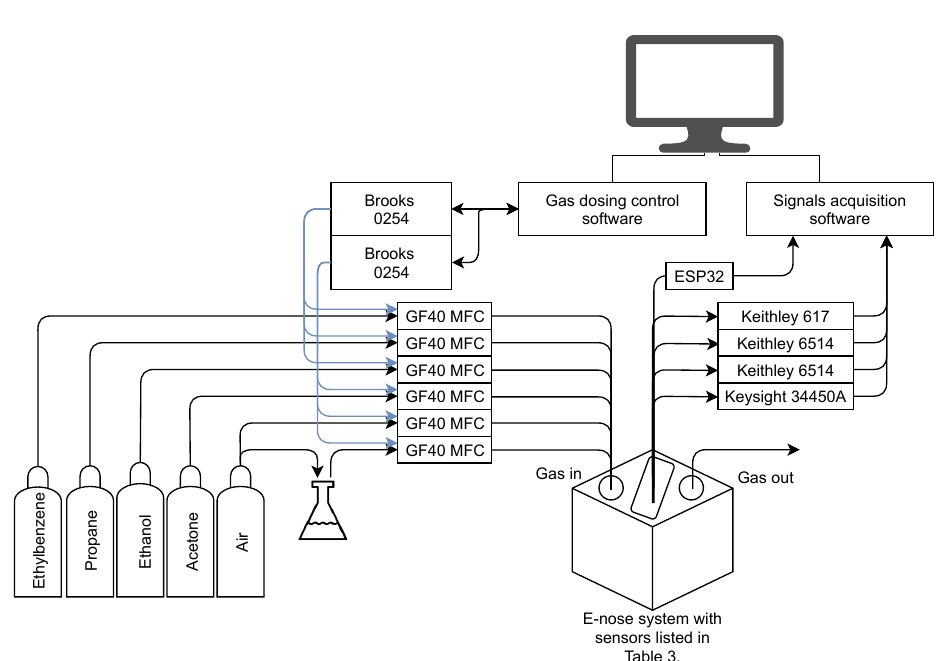
E-nose system with sensors listed in